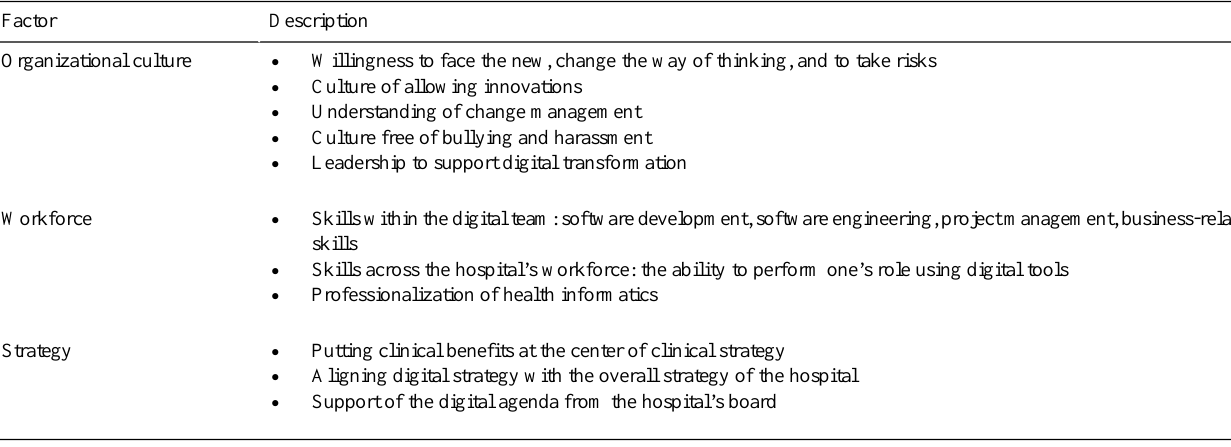
Table 5. Social and organizational factors contributing to digital